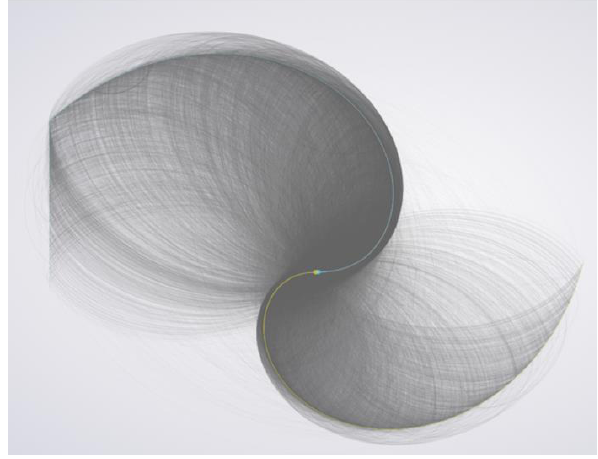
Figure 3. A social network graph by hashtag co-occurrences of 2628 nodes (hashtags) and 104,492 undirected edges (co-occurrences); Spatialization: Radial Axis Layout; Size: Weighted Degree; Color: Modularity Class 2 .